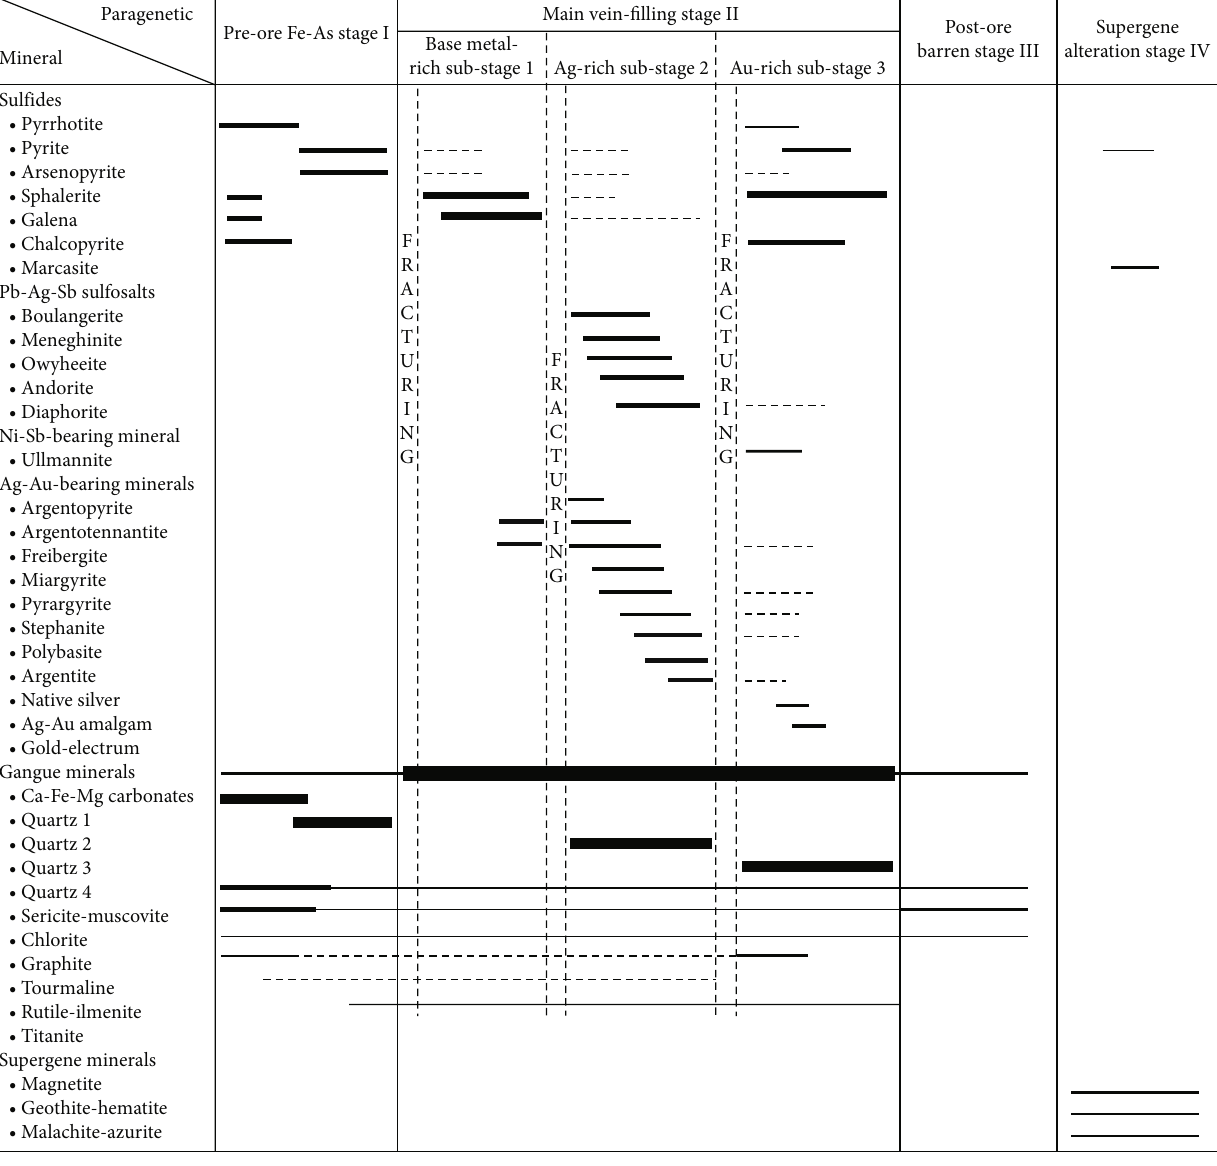
Figure 4: Paragenetic sequence of vein mineralisation of the Roc Blanc deposit (modi fi ed after